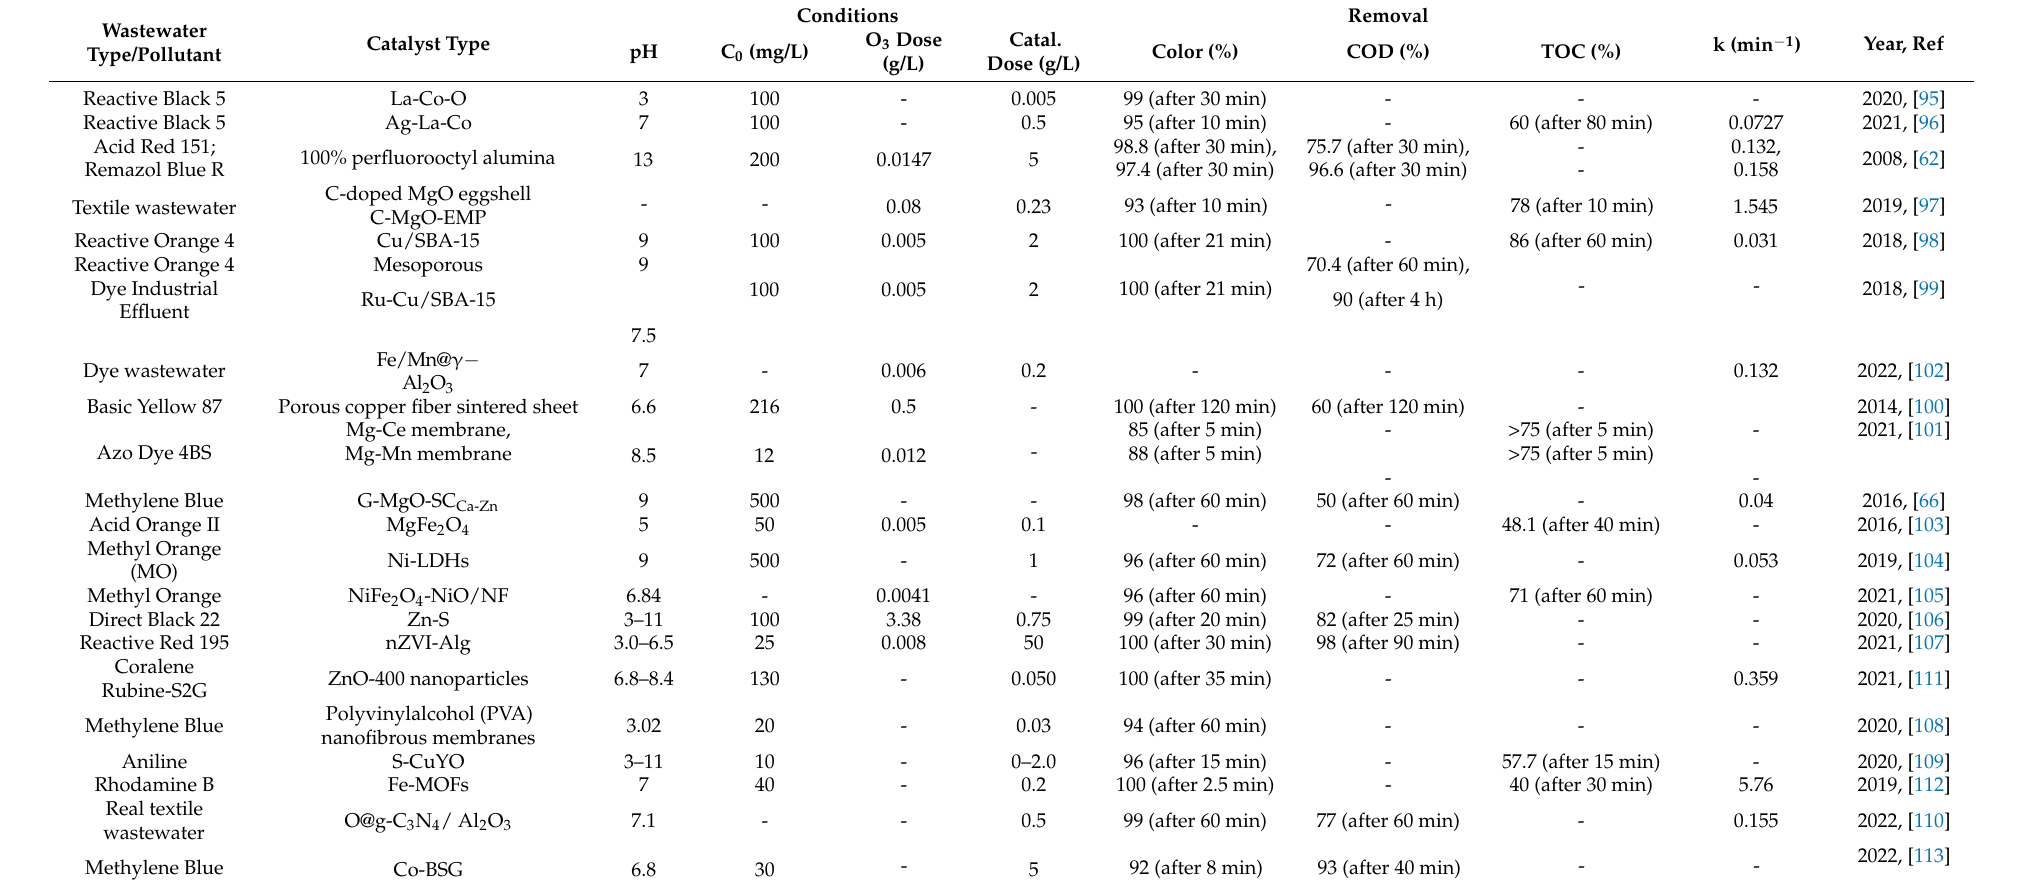
Table 6. Examples of catalytic ozonation with novel